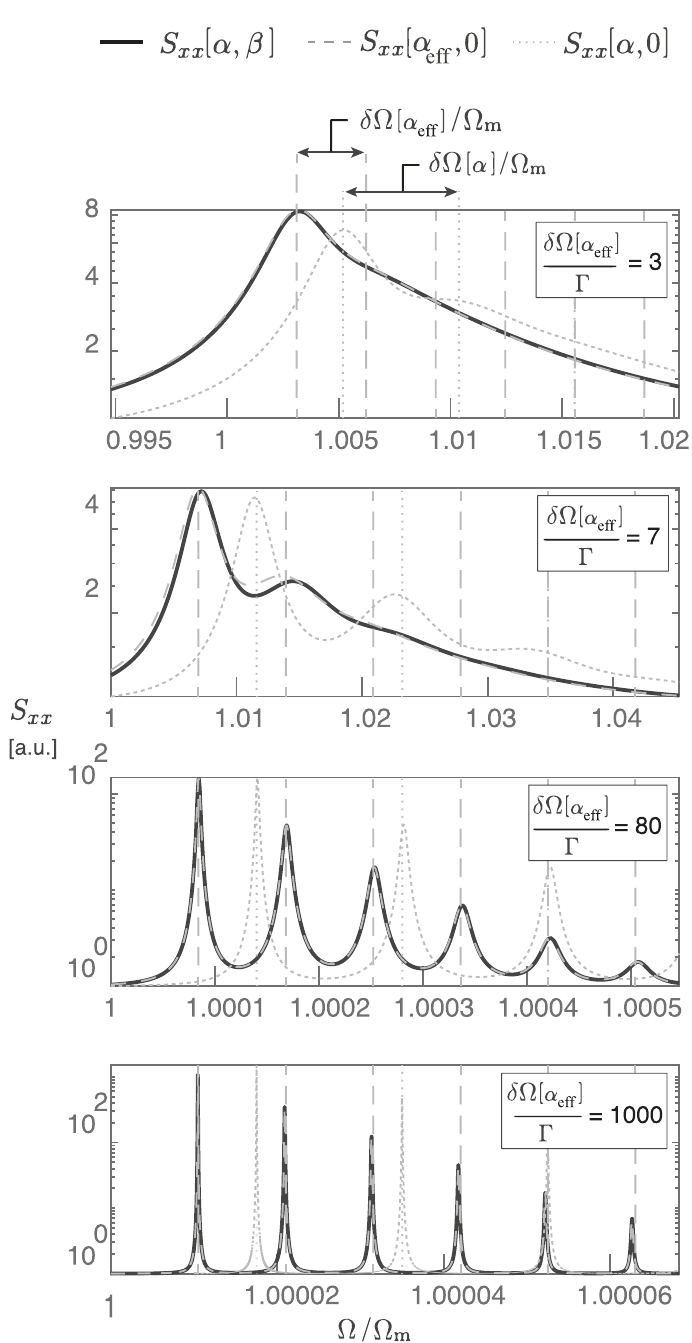
Fig. 4 Spectrum for open quantum system. Numerically simulated spectra for the full master equation with a quartic Duf fi ng ( α ) and cubic ( β ) nonlinearity of the potential ( S xx [ α , β ], solid lines), the approximated model where the cubic nonlinearity manifests as a correction to the quartic Duf fi ng strength ( S xx [ α eff , 0], dashed lines), and the spectra in absence of a cubic nonlinearity ( S xx [ α , 0], dotted lines). Vertical lines at ( E n + 1 − E n )/ _ for n = 0, 1, 2, … indicate the analytic values of transition energies according to Eq. (17) with δ Ω [ α eff ] (dashed) and δ Ω [ α ] (dotted). Input parameters: T = 50 mK, and from top to bottom: R = 3 nm, d = 5 nm, Q = 1 × 10 3 ; R = 3 nm, d = 25 nm, Q = 1 × 10 3 ; R = 10 nm, d = 5 nm, Q = 1 × 10 6 ; R = 20 nm, d = 5 nm, Q = 1 × 10 8